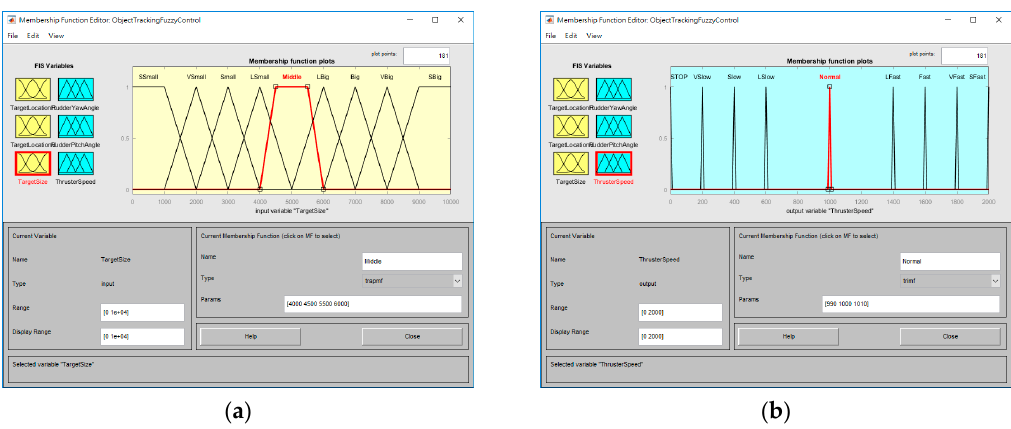
Figure 10. Interfaces of ( a ) the input variable of membership of the range for the object on the visual plane and ( b ) the output variable of membership of propeller revolution speed. Table 2. Rules for the vertical rudder plane.